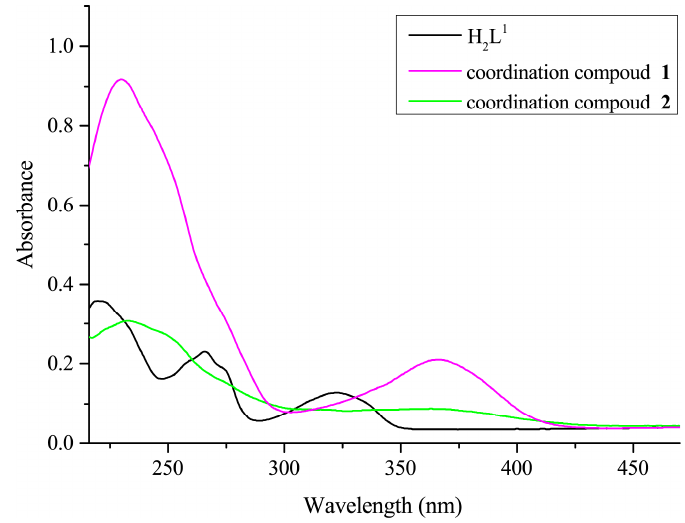
Figure 2. UV-vis spectra of H 2 L 1 and coordination compounds 1 and 2 in methanol (c = 2.5 × 10 − 5 M). Table 2. Selected bond lengths (Å) and angles (°) of coordination compounds 1 and 2 . Coordination Compound 1